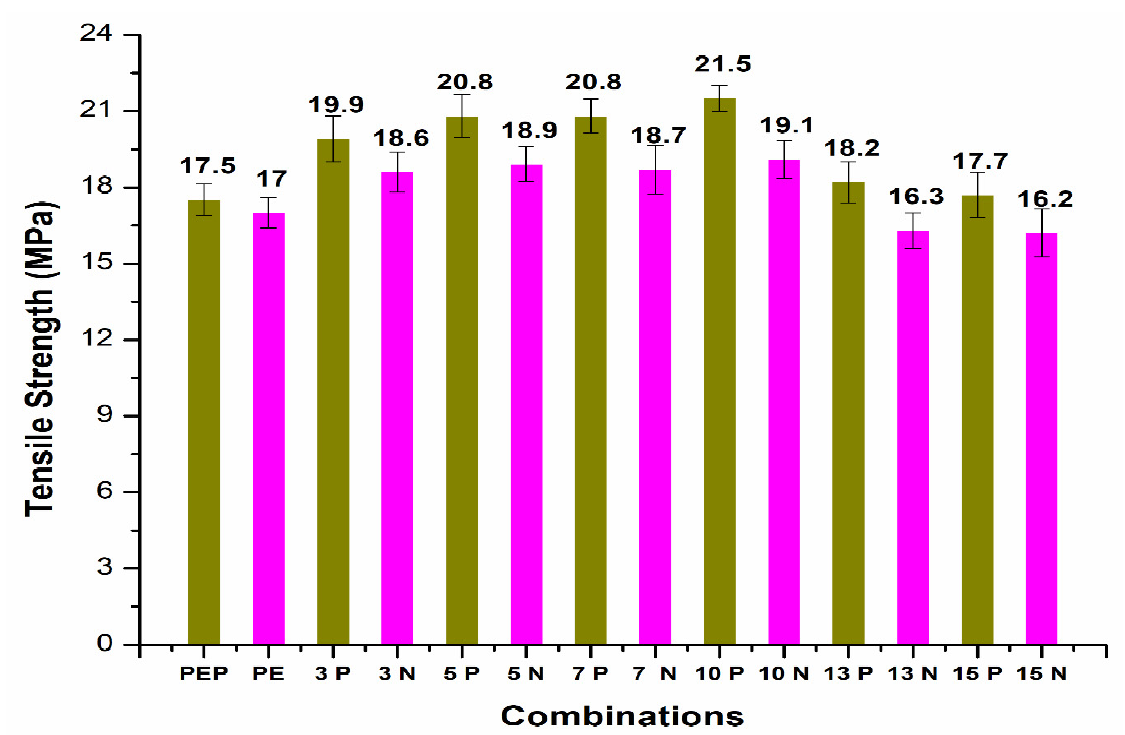
Figure 2. Tensile strength of CF/PE composites. The best results were observed with 10 wt.% CF, with a maximum tensile strength of 21.5 MPa and improvement in the properties up to 12.57% compared to non-plasma PE